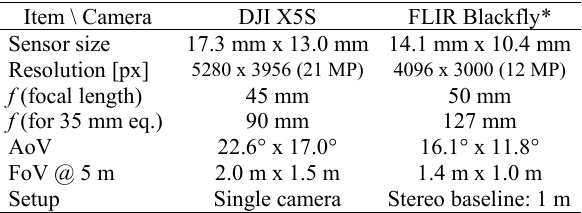
Table 1. Cameras parameters. AoV: angle of view; FoV: field of view; *Blackfly model: